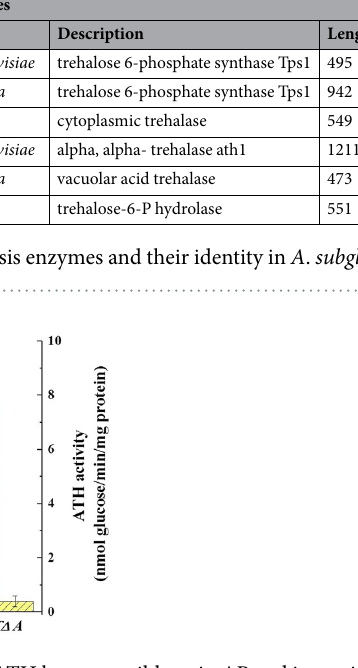
Figure 2. The enzyme activities of TPS and ATH between wild strain AP and its engineered strains AP tps1 , AP ∆ ath1 and AP T ∆ A were compared. Each error bar indicates + / − one standard error of the